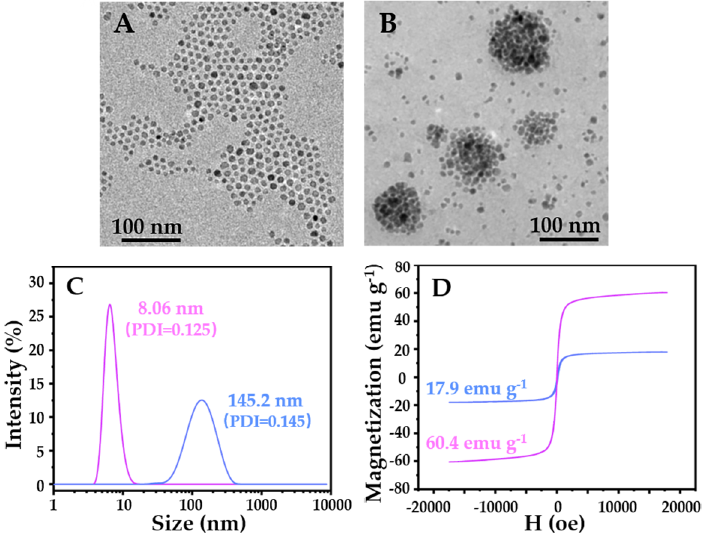
Figure 4. Characterization of the Fe 3 O 4 nanoparticles and MNF, including the morphologies (TEM), particle size distributions (DLS) and magnetic properties (magnetic hysteresis loops): ( A ) TEM result of the hydrophobic Fe 3 O 4 nanoparticles in hexane (0.1 mg mL − 1 ); ( B ) TEM result of the MNFs in alkaline buffer (pH ≈ 9.0, 0.5 mg mL − 1 ); ( C ) DLS results of the samples in ( A , B ); ( D ) magnetic properties of the desiccative Fe 3 O 4 nanoparticles (60.4 emu g − 1 ) and MNF (17.9 emu g − 1 ).